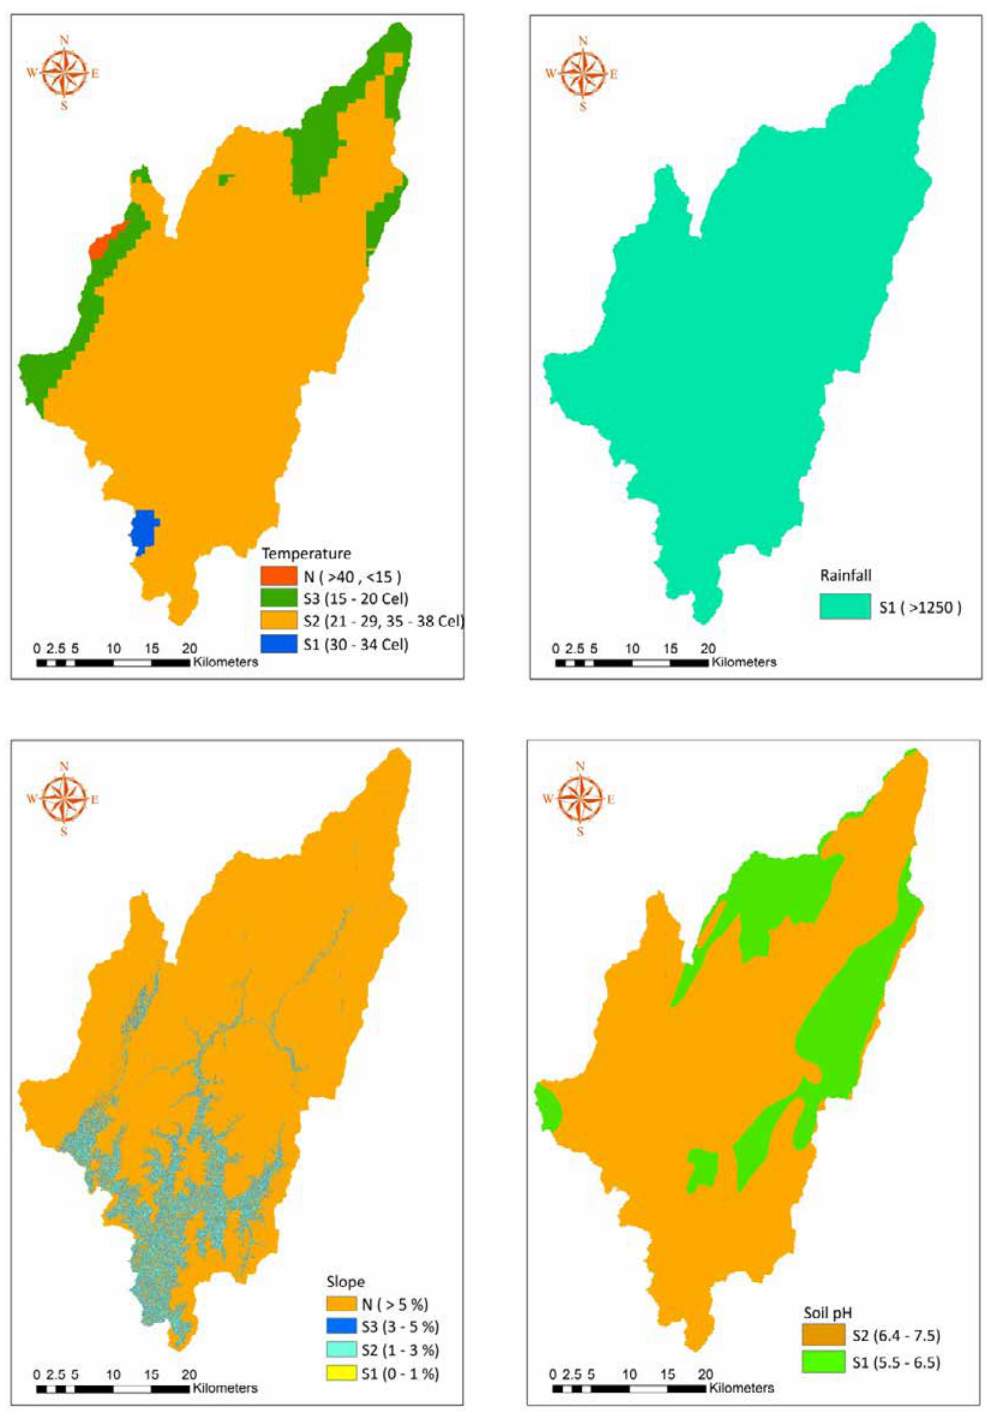
Fig. 3: Suitability level for selected parameters: temperature, rainfall, soil texture,slope,pH, soil depth, soil drainage and land use land cover